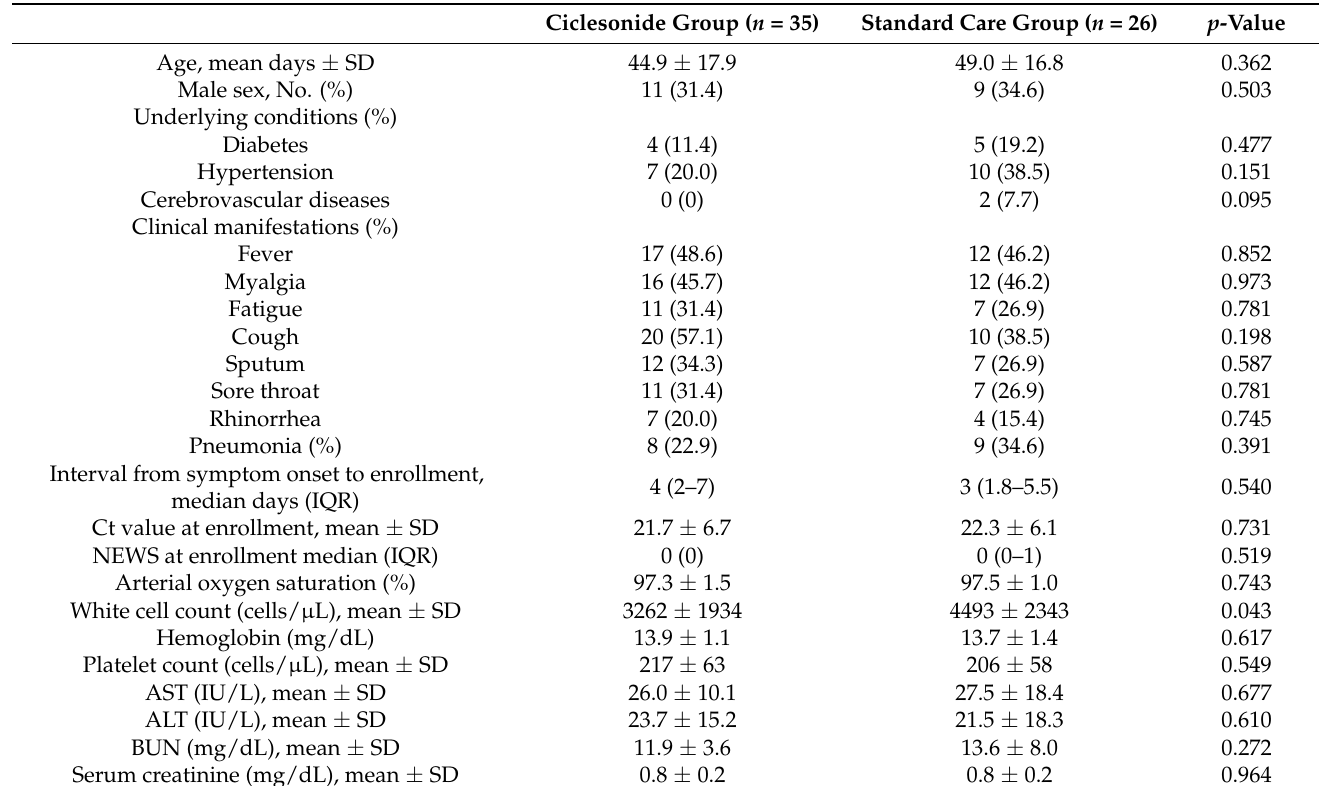
Table 1. Baseline demographic and clinical characteristics of study